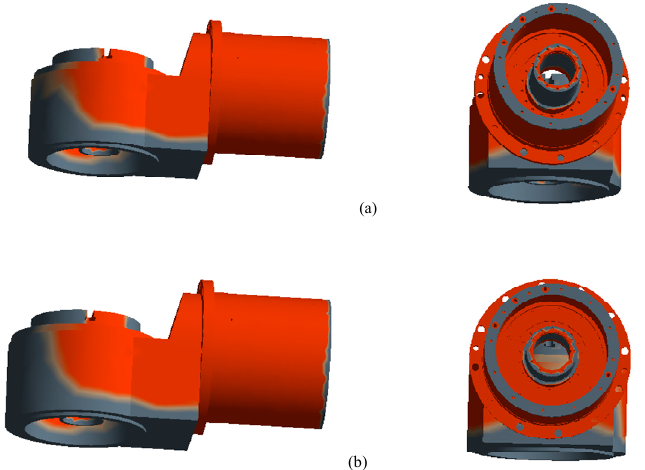
Figure 19. Topology optimization results of direct-drive turntable in milling condition: ( a ) 50% mass retention rate; ( b ) 60% mass retention rate.